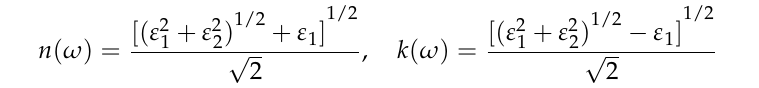
0.87 Ga 0.13 As 0.25 P 0.75 bulk and In 0.87 Ga 0.13 As 0.25 P 0.75 (001)